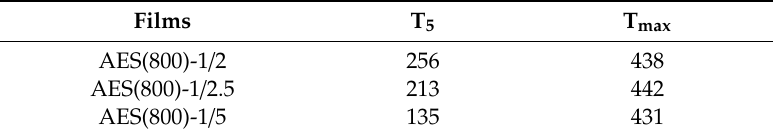
Figure 12. Experimental TGA and DTGA traces for AES(800)-1/2, AES(800)-1/2.5 and AES(800)-1/5 obtained at a heating rate of 10 °C/min. Table 4. Data collected from TGA and DTGA traces.